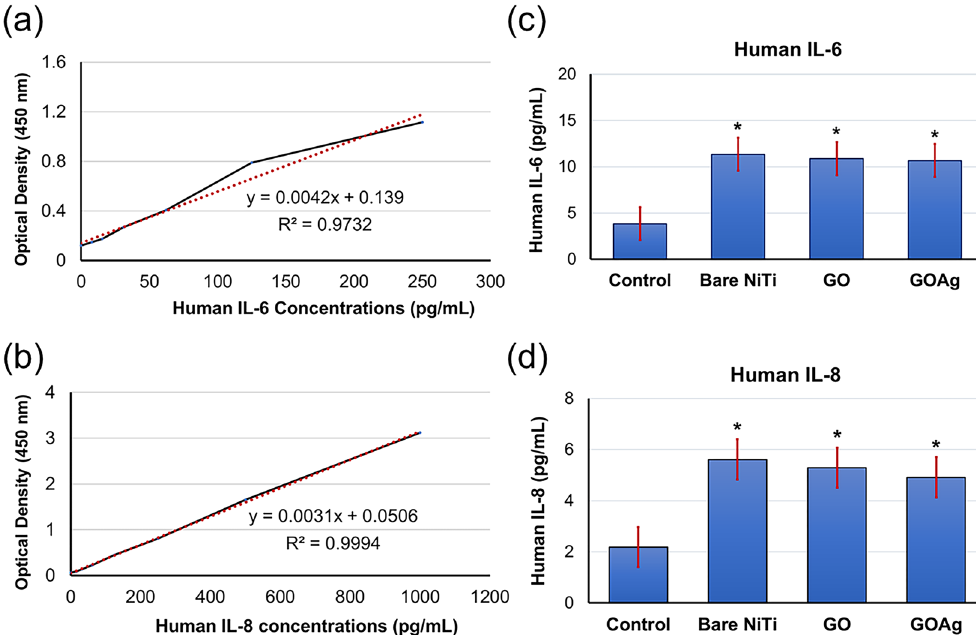
Figure 7. ( a ) Standard curve of ELISA human pulp fibroblast cytokines IL-6, ( b ) Standard curves of ELISA human pulp fibroblast cytokines IL-8, ( c ) ELISA measurement of cytokines IL-6 levels, ( d ) ELISA measurement of cytokines IL-8 levels. * Indicates a significant difference of cytokines IL-6 and IL-8 levels of the bare NiTi, GO-coated NiTi (GO), and GO/Ag-coated NiTi (GOAg) alloy compared to the control (P <